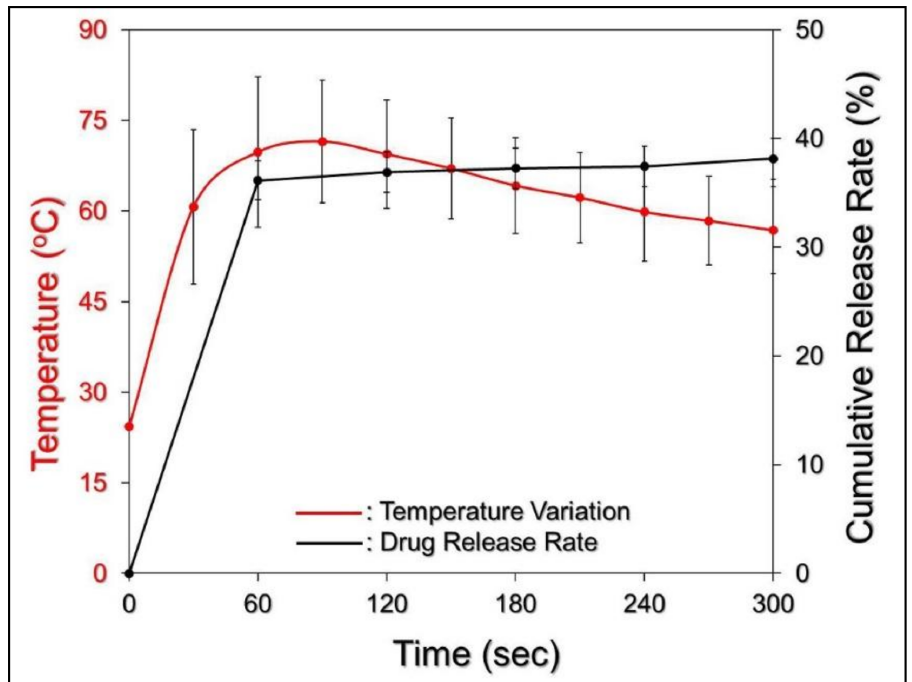
Figure 8. The MMC release profile of the EIMPDNEs under NIR illumination in vitro. The black curve represents the cumulative release profile of the EIMPDNE-entrapped MMC (black) under NIR exposure (808 nm; 6 W cm − 2 ) and was plotted by measuring the concentrations of MMC in the bulk phase through spectrophotometry at λ = 485 nm after treatment for 0, 1, 2, 3, 4, and 5 min. The red curve indicates the temperature variation of the EIMPDNE-containing medium with 40 µ M of ICG equivalent concentration under NIR exposure for 5 min. Values are mean ± s.d. ( n =